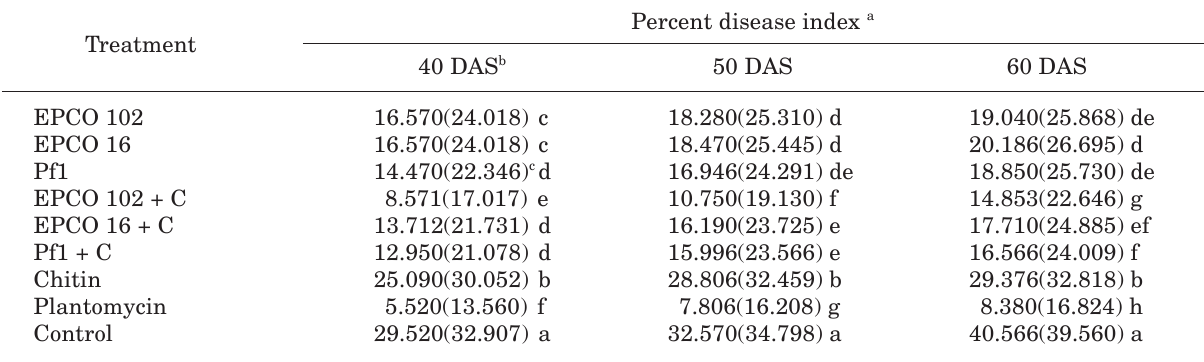
Table 2. Effectiveness of bacterial endophytes against bacterial blight of cotton under greenhouse